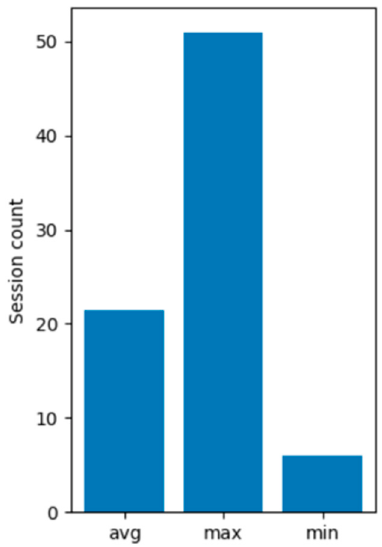
Figure 2. The number of sessions generated by each user.